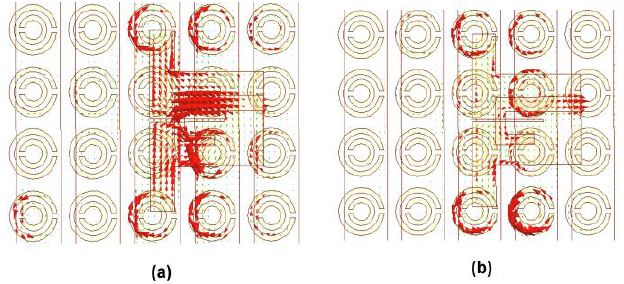
Figure 9: Simulated surface current distributions on the structure at a) 3.23 GHz and b)3.52 GHz